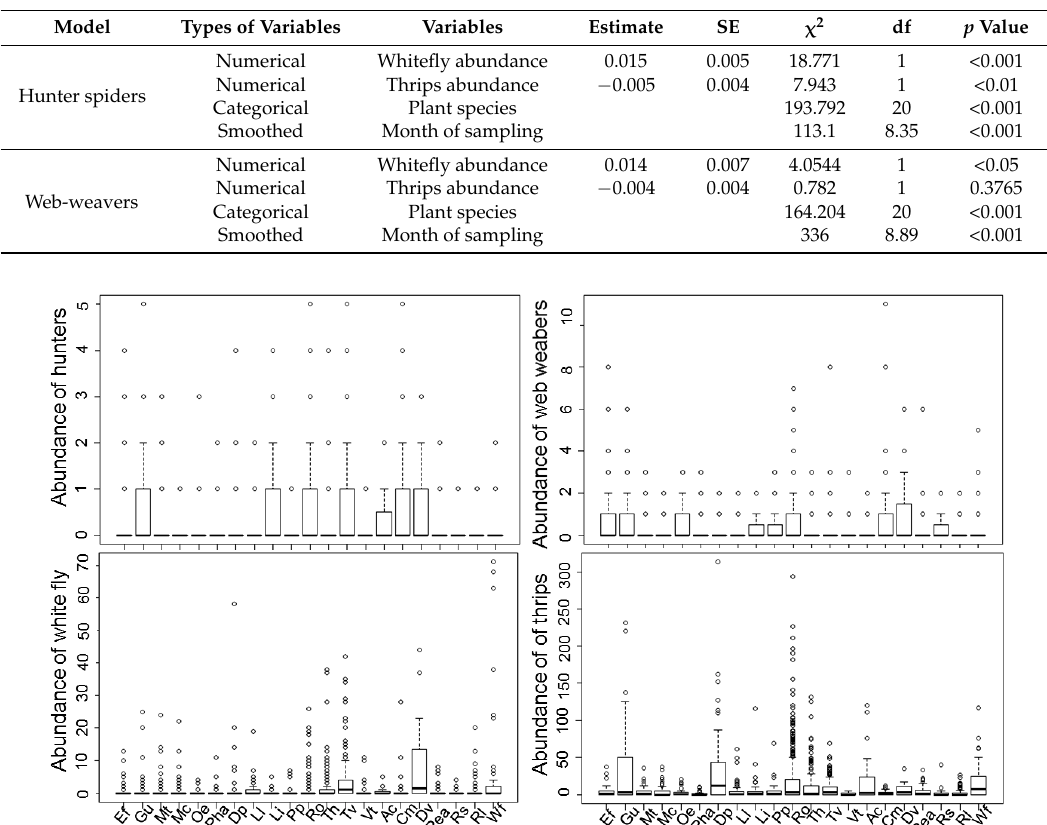
Table 3. Results of the Generalized Additive Model (GAM) analysing the abundance of spider guilds in 21 native shrubs with different abundance of pests and sampling period as covariates.